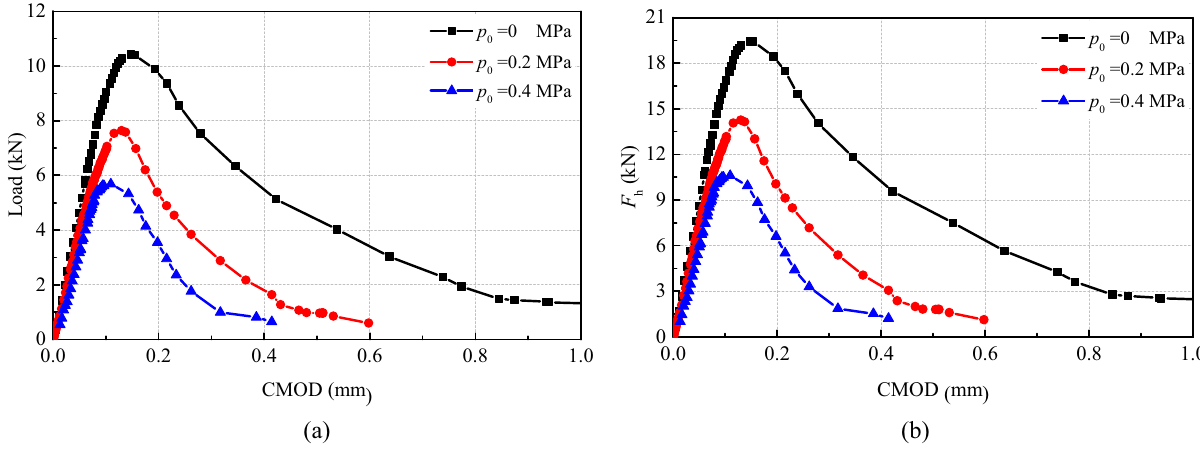
Figure 3: Load – CMOD curves with di ff erent outlet water pressures. ( a ) Measured initial force F 0 and ( b ) calculated horizontal splitting force F h .